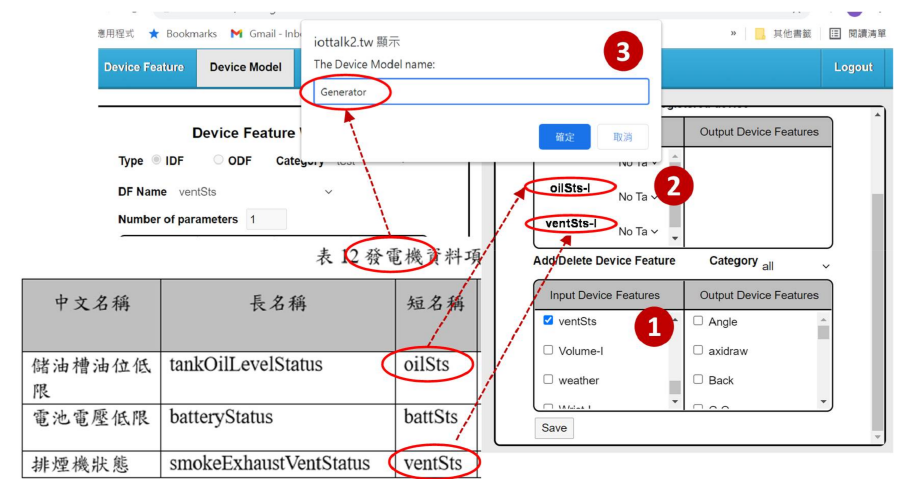
Figure 5. Device Feature (DF)